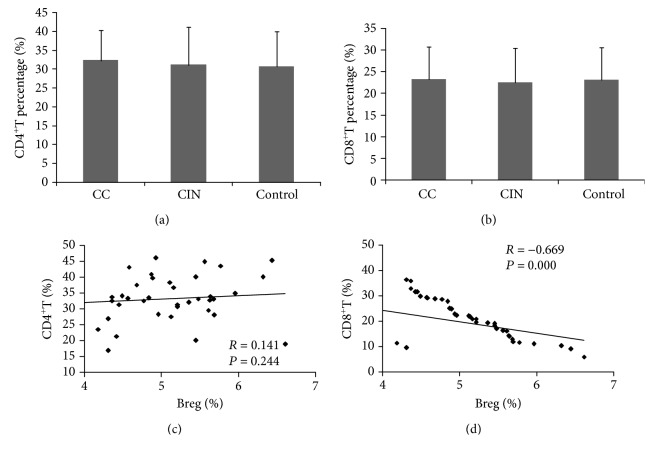
Correlation analyses between Breg and T subsets: (a) alteration of CD4+ T cells in patients; (b) alteration of CD8+ T cells in patients; (c) correlation between Breg and CD4+ T cells; (d) correlation between Breg and CD8+ T cells (r = ‐0.669, P ≤ 0.001).